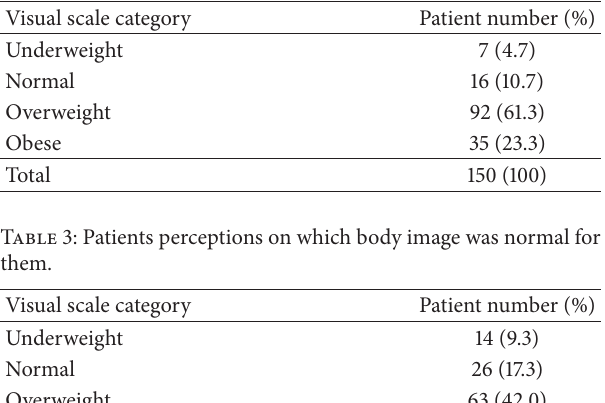
Table 2: Patients’ perceptions of their body image using a visual scale.